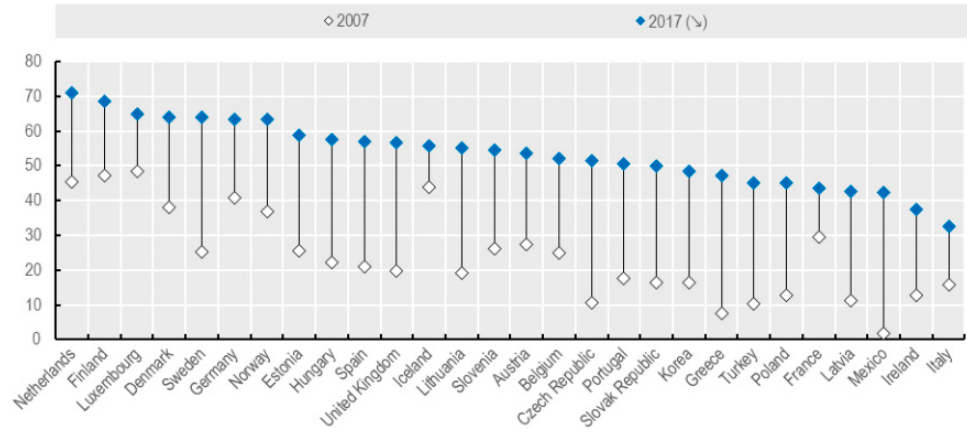
Figure 2. Increase in the percentage of people using the Internet for medical purposes between 2007 and 2017 [21]. and 2017